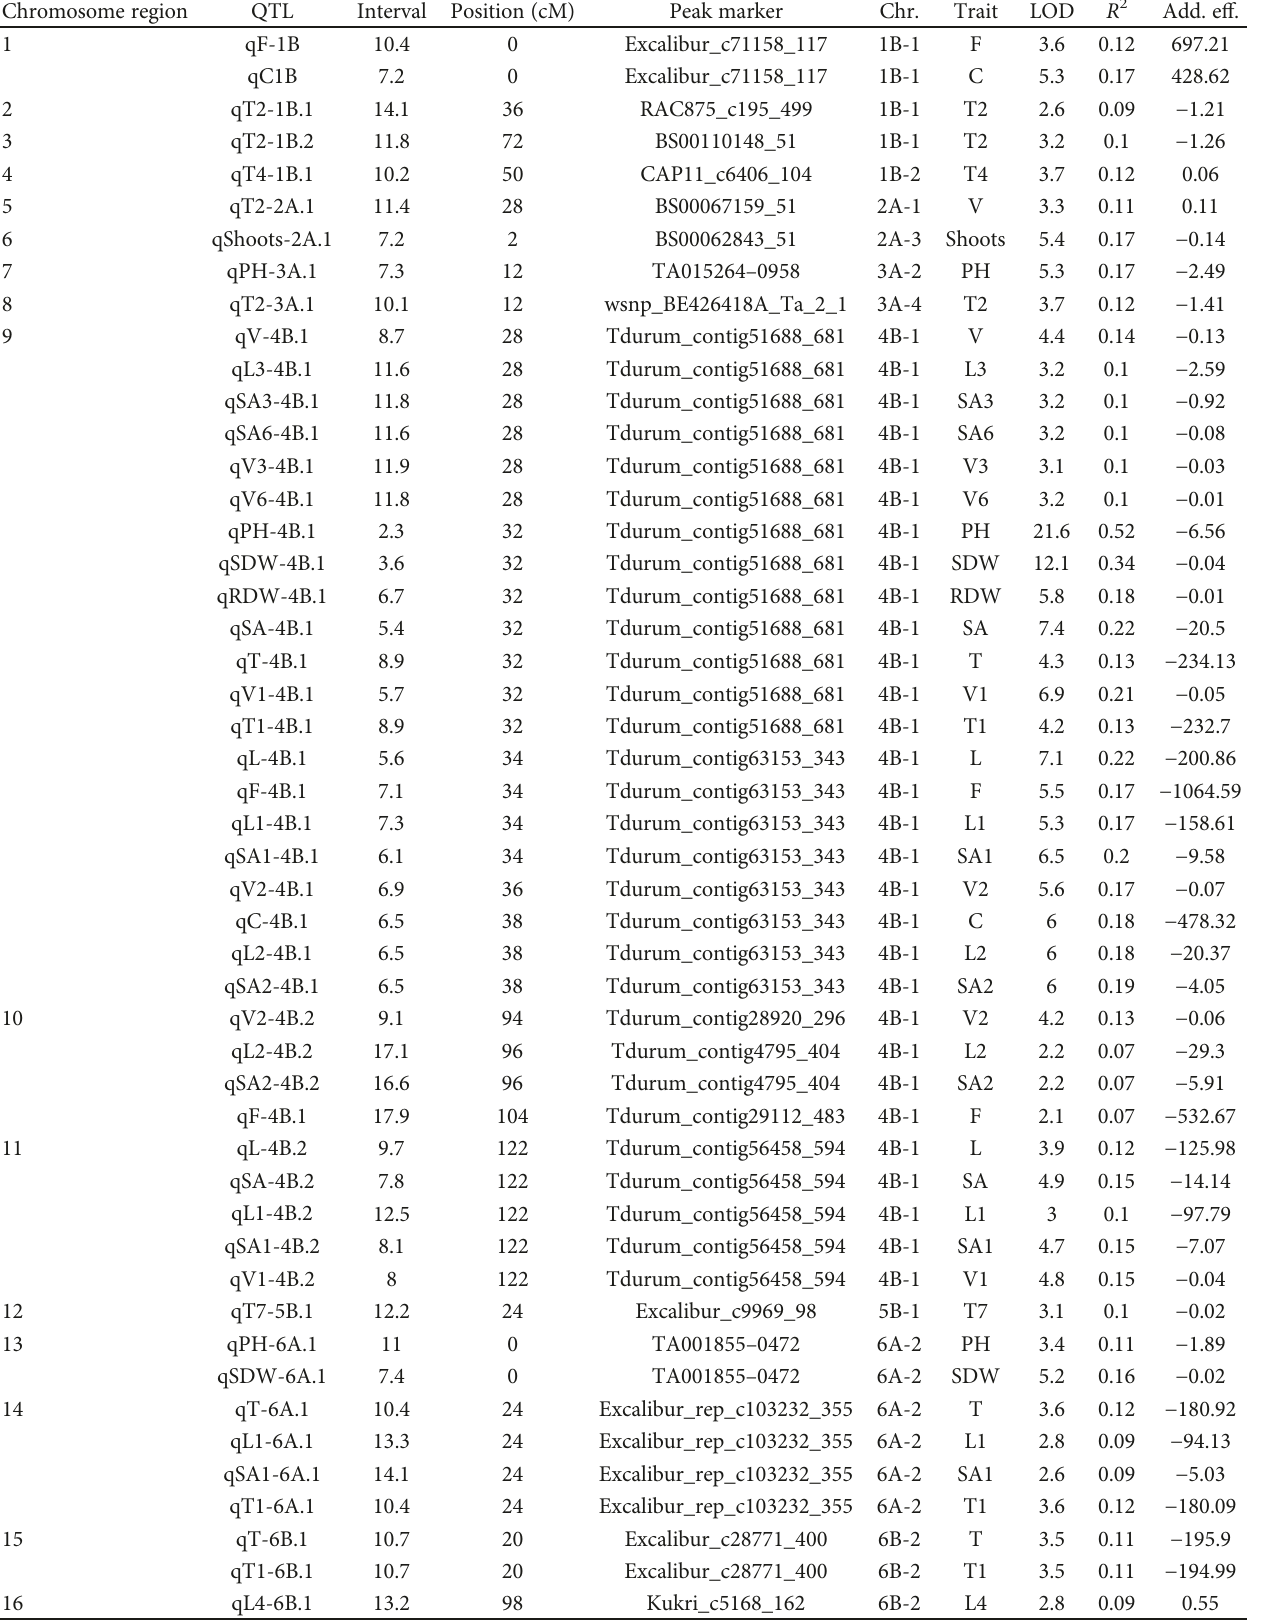
Table 3: QTL detected in the “ Simeto ” × “ Molise Colli ” RIL populations for the evaluated